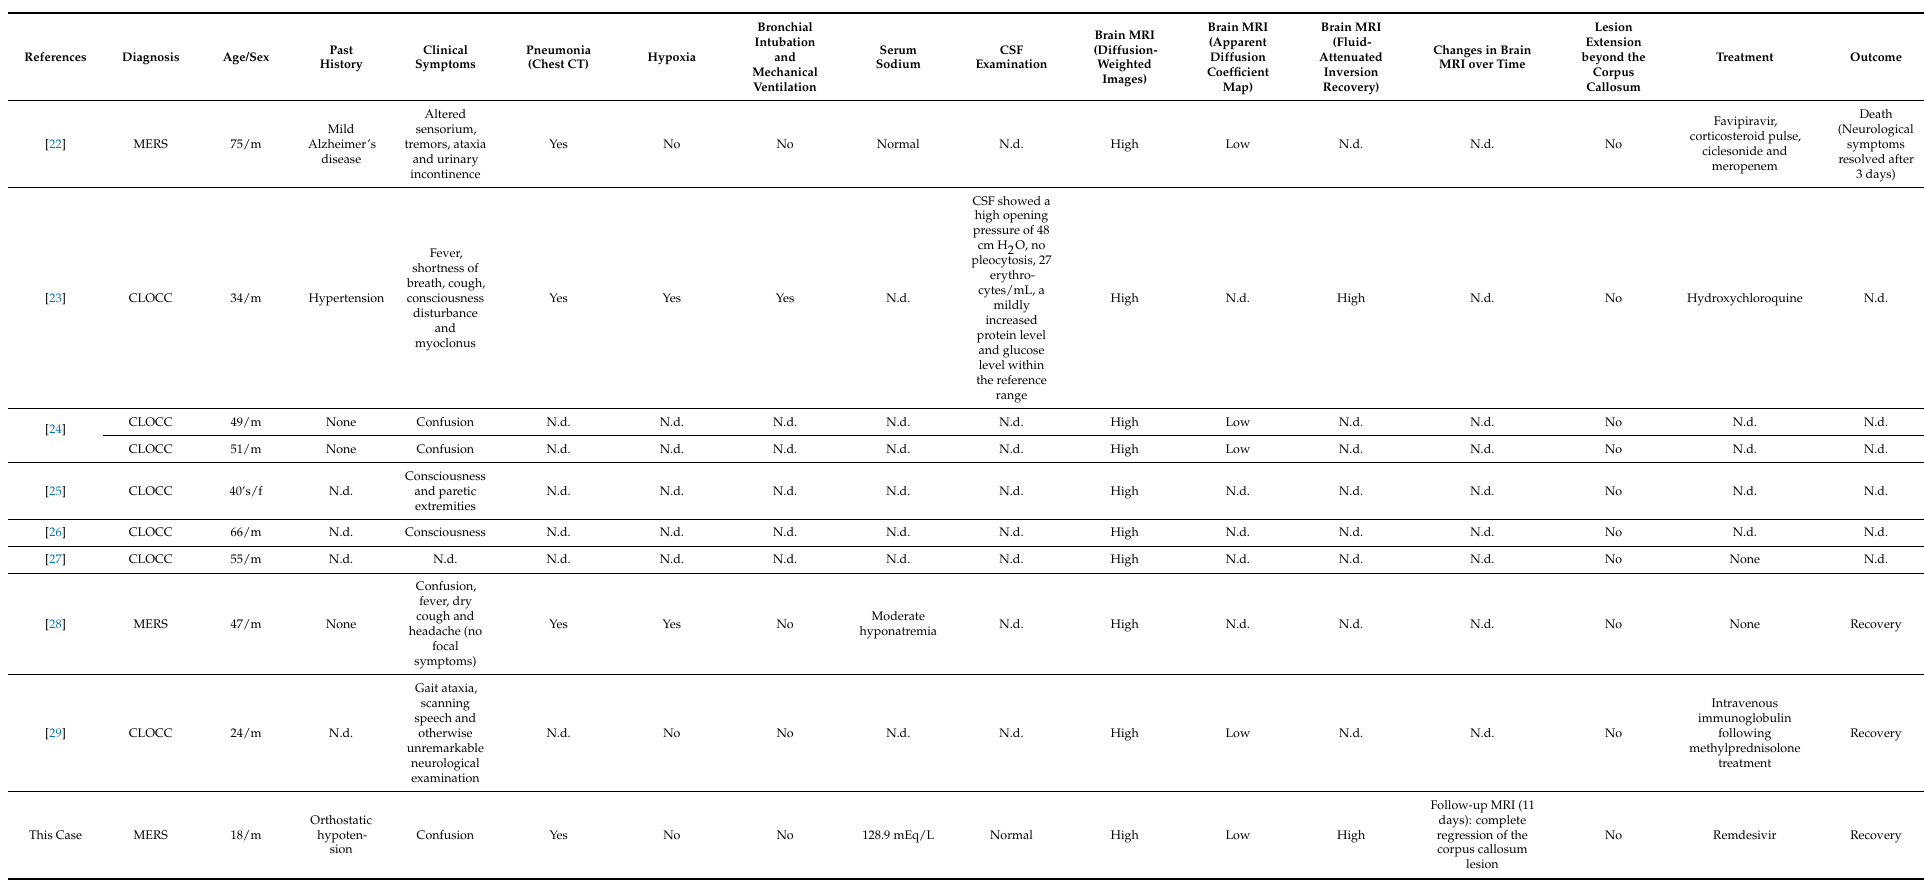
Abbreviations: MERS, clinically mild encephalitis/encephalopathy with reversible splenial lesions; CLOCC, cytotoxic lesions of the corpus callosum; CSF, cerebrospinal fluid; CT, computed tomography; MRI, magnetic resonance imaging; N.d., no